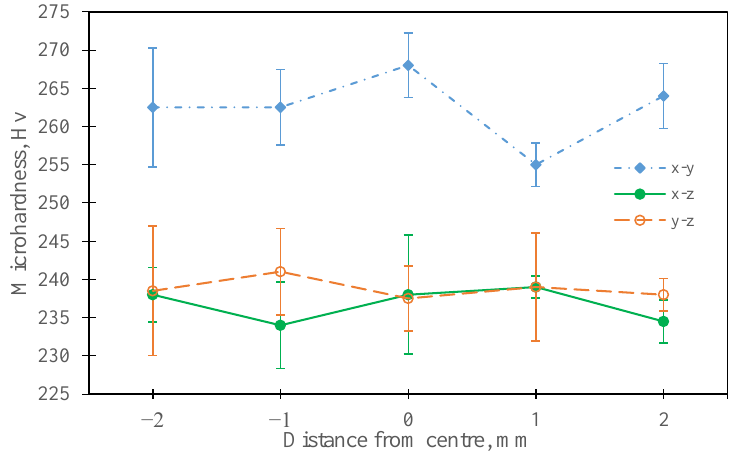
Figure 10. Average microhardness (HV) values for SLM specimens in the x – y , x – z and y – z planes.